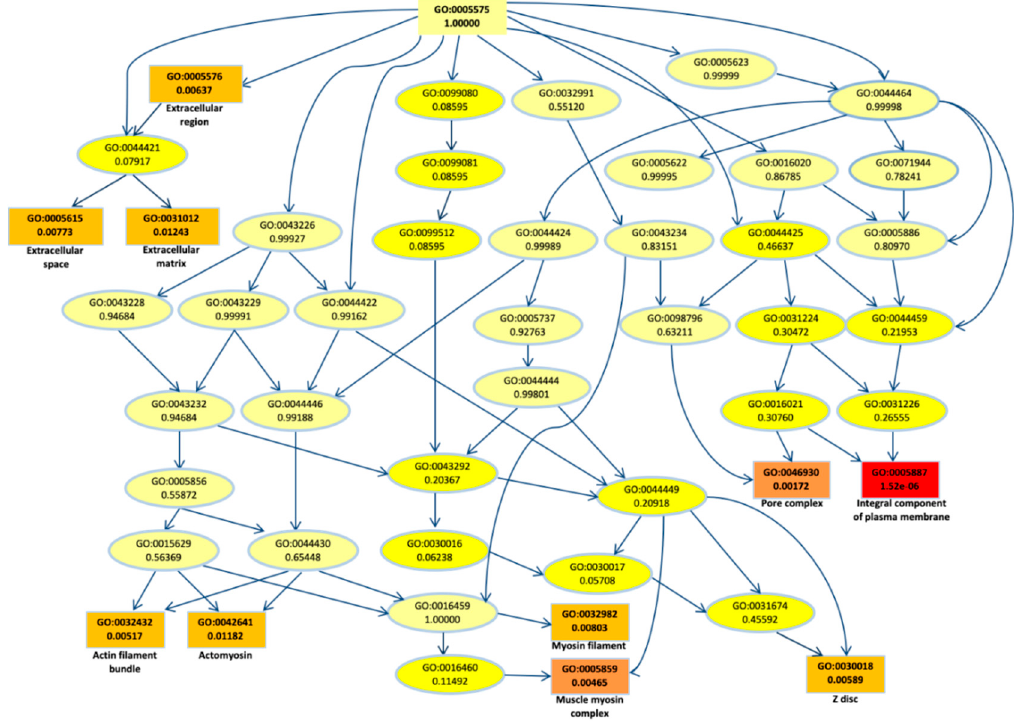
Figure 2. Gene ontology (GO) graph related to the top 10 most enriched terms. Significant GO accession codes are reported in rectangles and statistical significance is shown in color scale that ranges from yellow to red (low to high significance). At the right side, the descriptions related to the significant terms are reported.